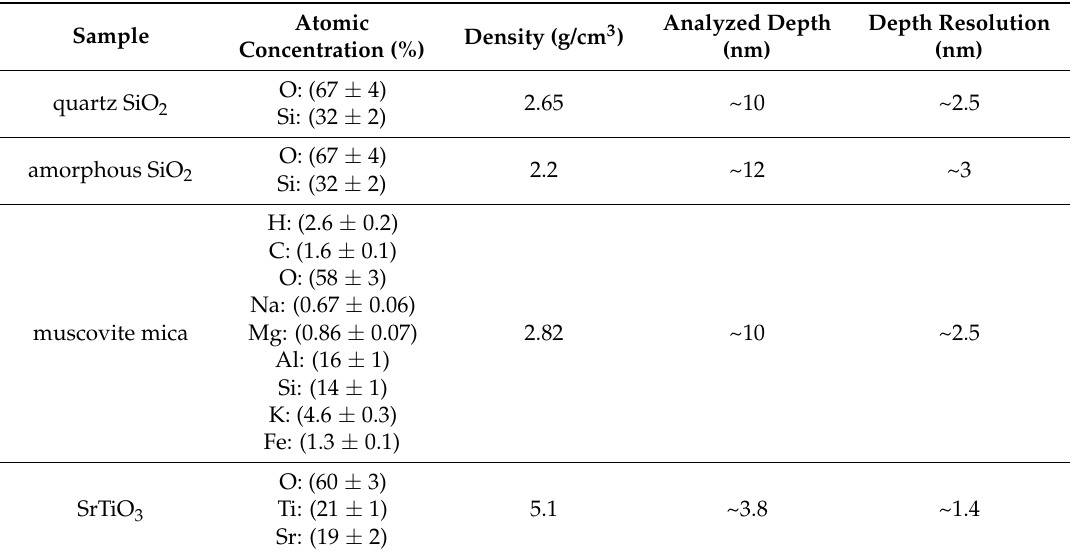
Table 1. Calculated “surface” atomic concentrations for quartz SiO 2 , amorphous SiO 2 , muscovite mica, and SrTiO 3